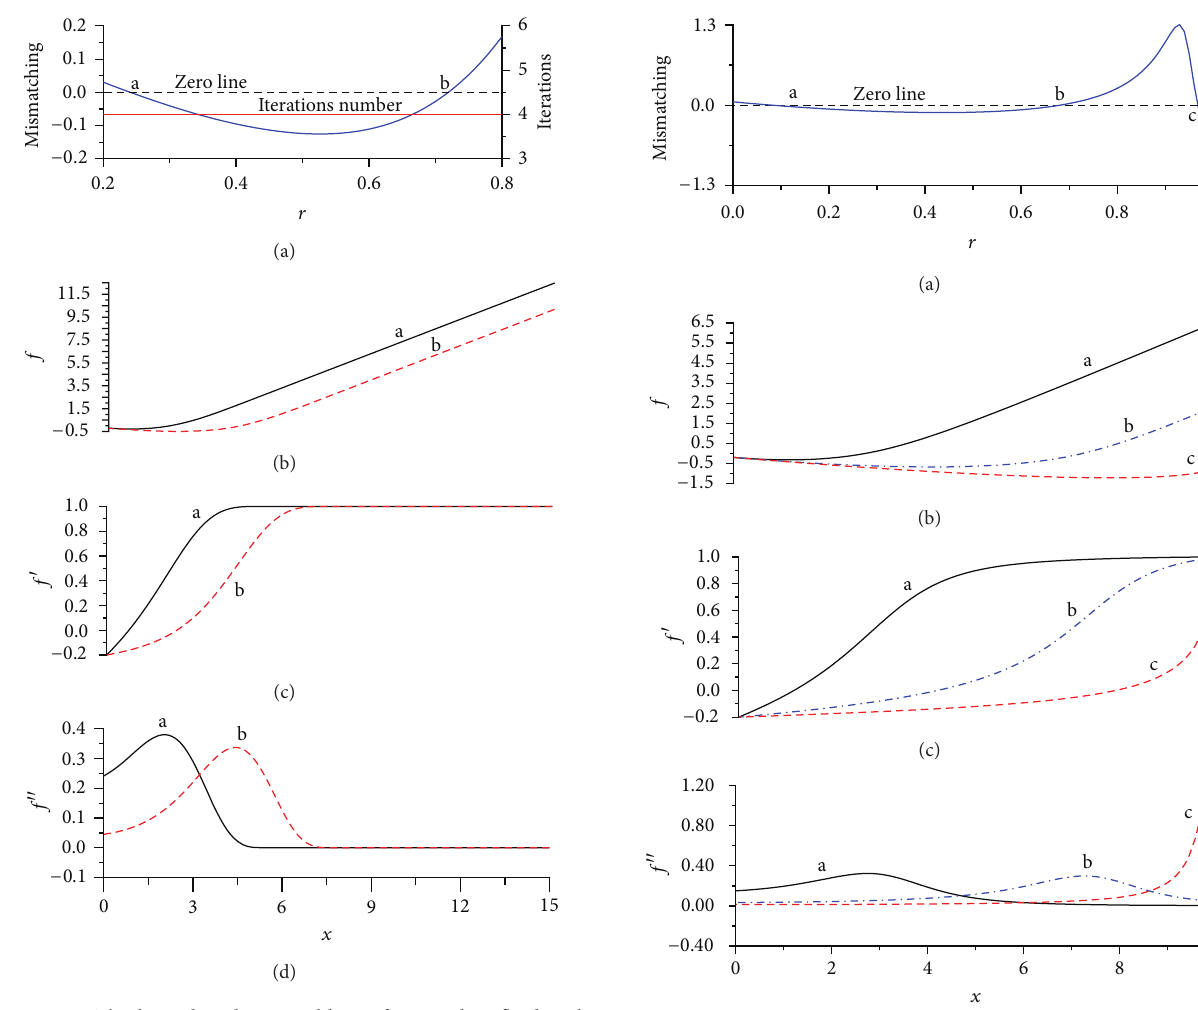
Figure 10: The boundary layer problem of power-law fluid with 𝑁 = 1.2 solved by the SL (3, R ) method, (a) showing the error of mismatching and iterations number and showing two different numerical solutions of (b) 𝑓 , (c) 𝑓 󸀠 , and (d) 𝑓 󸀠󸀠 .